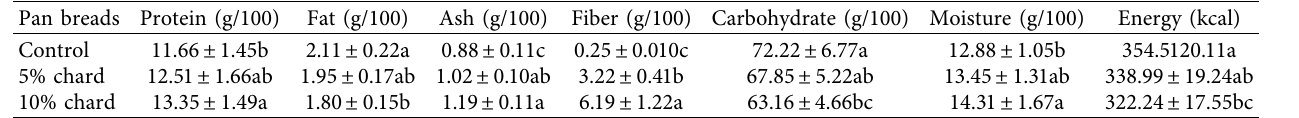
Table 4: Chemical composition in the control, 5% chard, and 10% chard pan breads. Pan breads Protein (g/100)